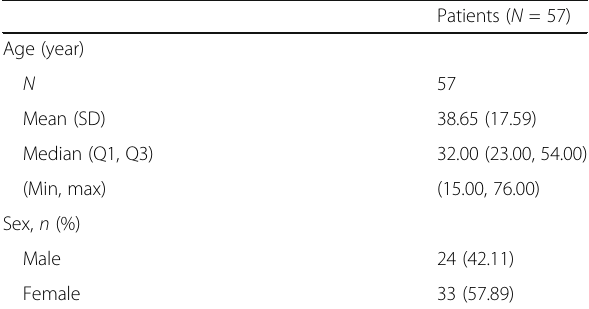
Table 1 Baseline characteristics